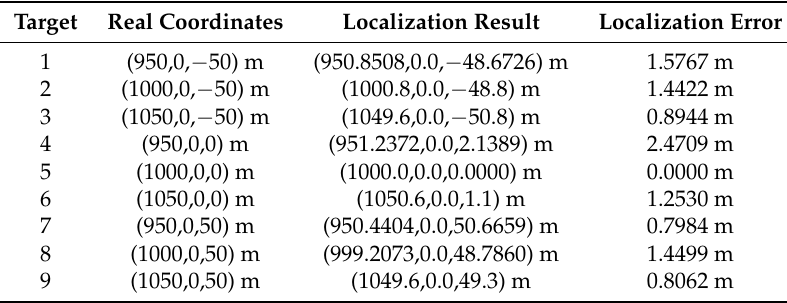
Table 3. Imaging reference target localization error simulation